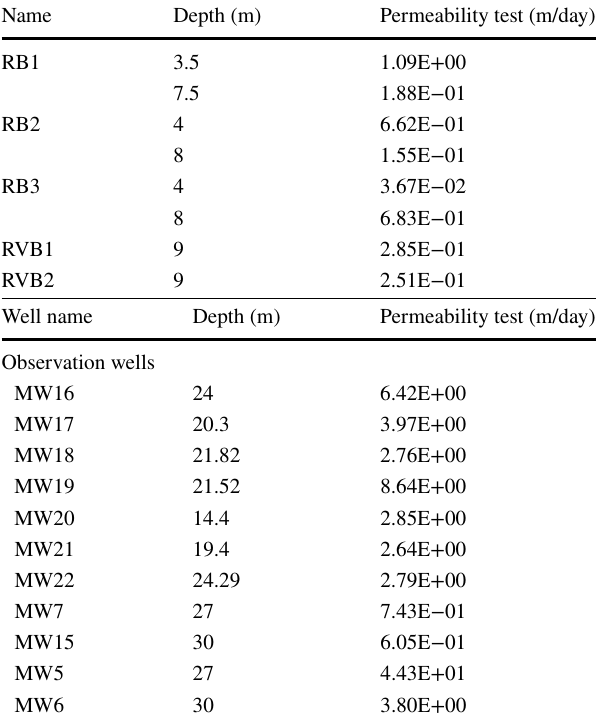
Table 8 Field permeability test from falling head test versus depths for riverbed and riverbanks from observation wells